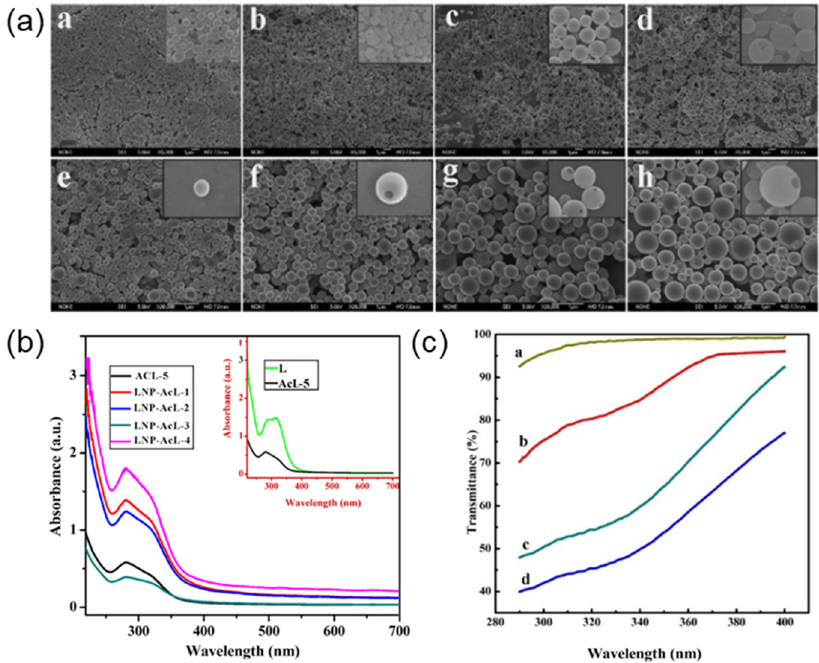
Figure 6. ( a ) SEM of prepared LNPs; ( b ) UV spectrum of ACL and LNP-AcL; ( c ) UV- resistance effect of LNP and LNP-AcL. Reprinted with permission from Ref. [12]. Copyright 2018 American Chemical Society.